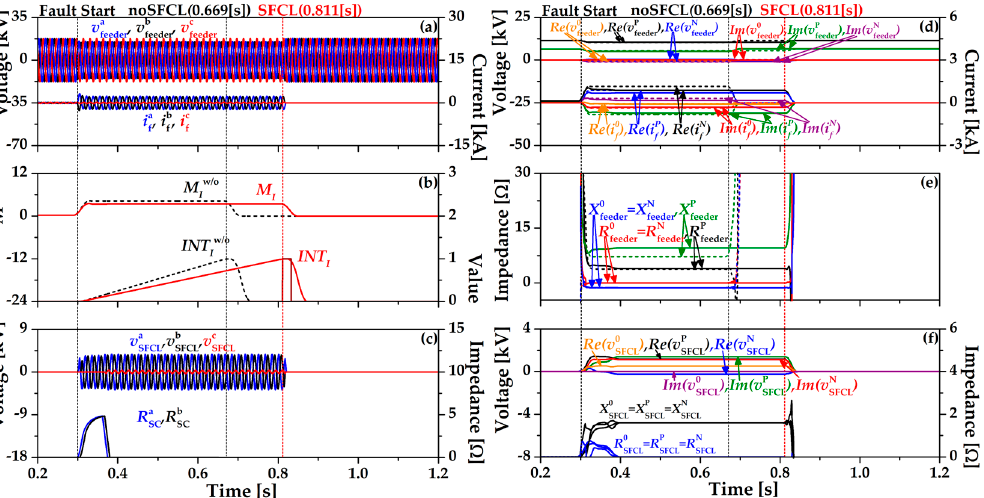
Figure 6. Waveforms and signals of OCR using M I in DLG. ( a ) Three phase feeder voltage ( v feeder ), current ( i f ). ( b ) Index of CB ( M I ) and signal of OCR ( INT I ). ( c ) Three phase SFCL voltage ( v SFCL ), HTSC element ( R aSC , R bSC ). ( d ) Sequence feeder voltages ( v 0 feeder , v Pfeeder , v Nfeeder ), sequence feeder currents ( i 0 f , i Pf , i Nf ). ( e ) Sequence feeder impedances ( R 0 feeder , R Pfeeder , R Nfeeder , X 0 feeder , X Pfeeder , X Nfeeder ). ( f ) Sequence SFCL voltages ( v 0 SFCL , v PSFCL , v NSFCL ) and sequence SFCL impedances ( R 0 SFCL , R PSFCL , R NSFCL , X 0 SFCL , X PSFCL , X NSFCL ).